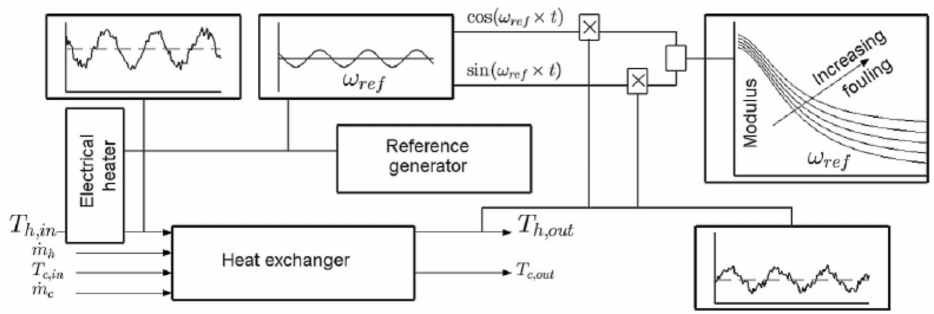
Figure 19. Implementation of a lock-in technique